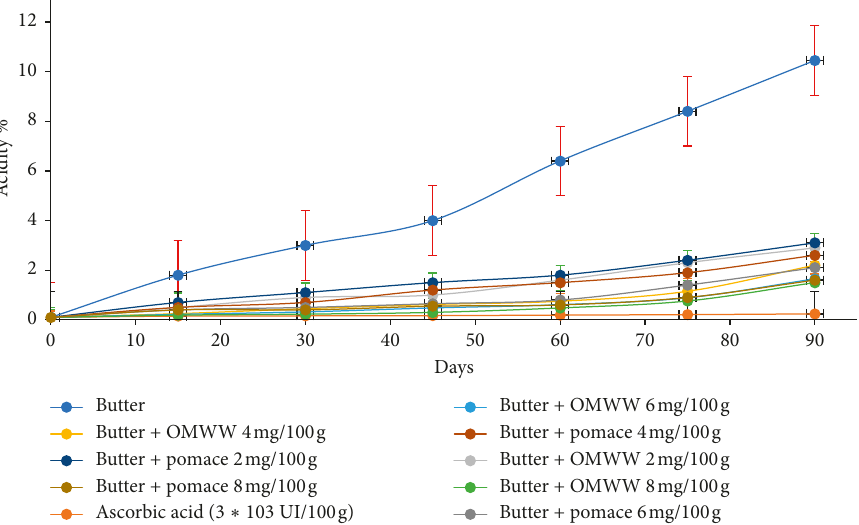
Figure 5: Evolution of the acidity as a function of the storage time of butter at 60 °